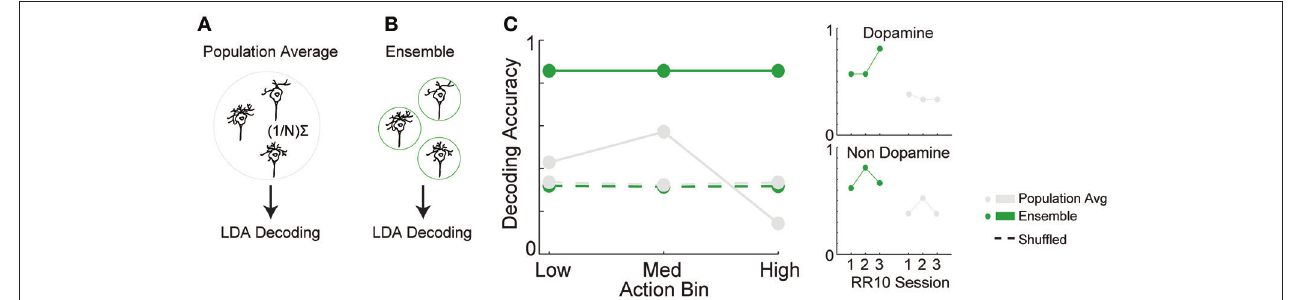
FIGURE 6 | Decoding binned action number from VTA neuronal activity. Linear discriminant analysis (LDA) utilized action-evoked activity averaged across (A) all neurons (population-average), or (B) the collective activity of each neuron (ensemble). (C) The proportion of correctly classified actions for each decoder. Dashed lines represent decoding of shuffled control data. Inset to the right depicts performance of ensemble and population-average decoders across consecutive sessions in dopamine and non-dopamine neurons. Note that ensemble activity was decoded significantly more accurately than population averaged activity and shuffled control. Inset data are collapsed across high, medium, and low action numbers and depicted separately for each